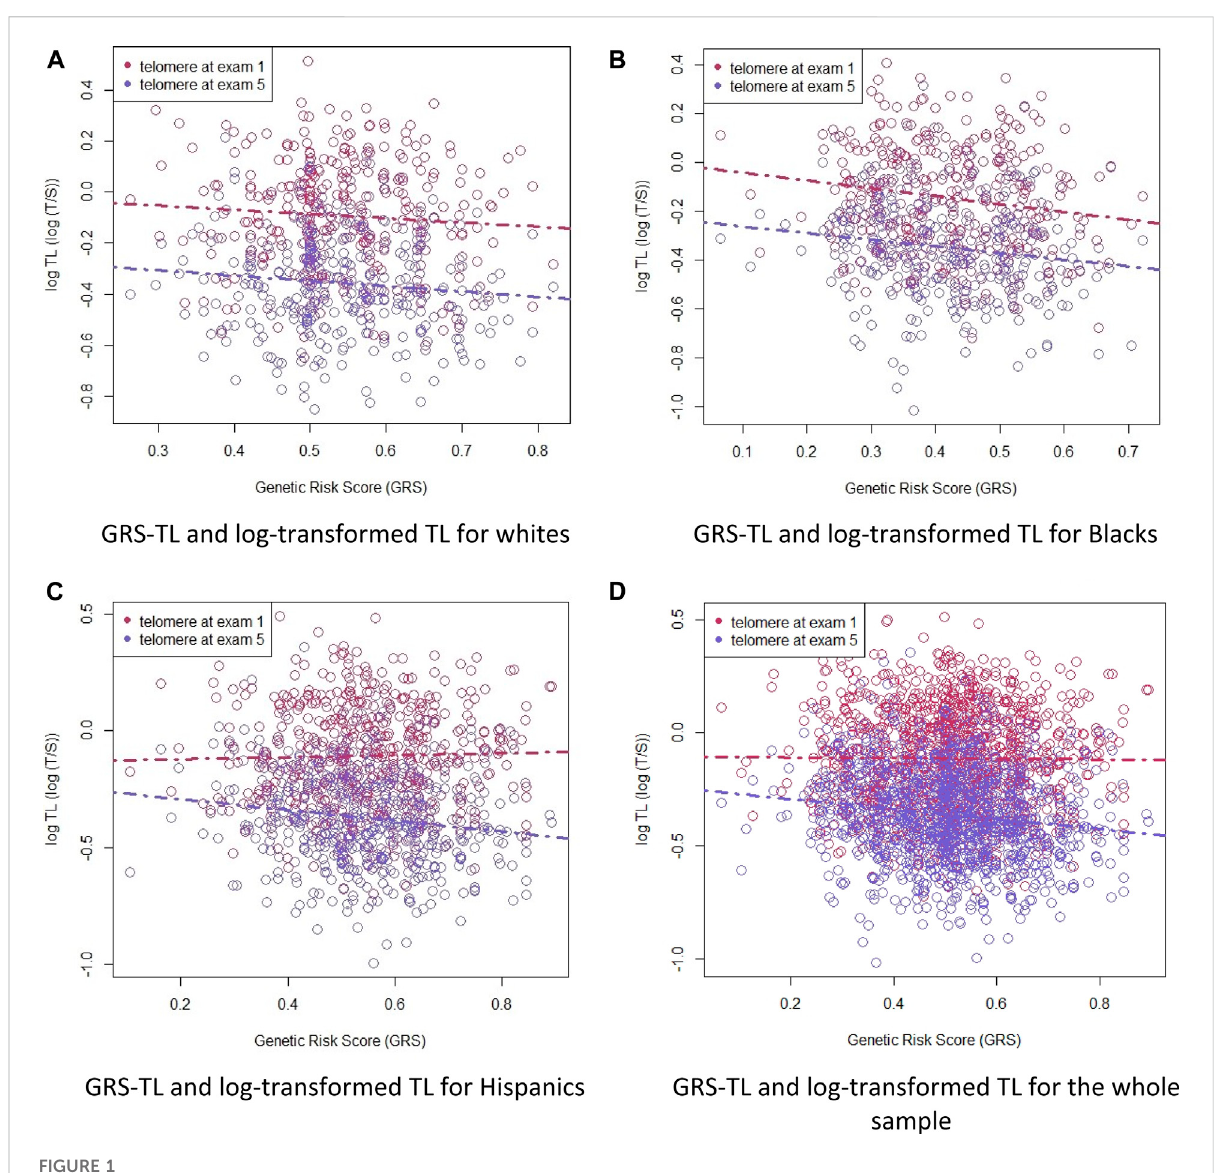
plottedaslogT/Sratio.Panel(A):GRS-TLandlog-transformedTLforwhites.Panel(B):GRS-TLandlog-transformedTLforBlacks.Panel(C):GRS-TL and log-transformed TL for Hispanics. Panel (D): GRS-TL and log-transformed TL for the whole